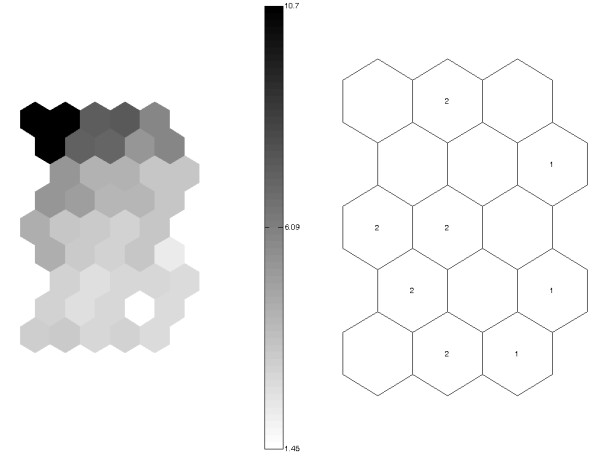
SOM of the Parkinson's disease model data. U-matrix and label map (panel on the right side). U-matrix depicts the distances between neighbouring map units using a grey scale. In the label map a node represents a class based on a majority voting strategy for the samples associated with this node. Additional file 4 shows its frequency map.